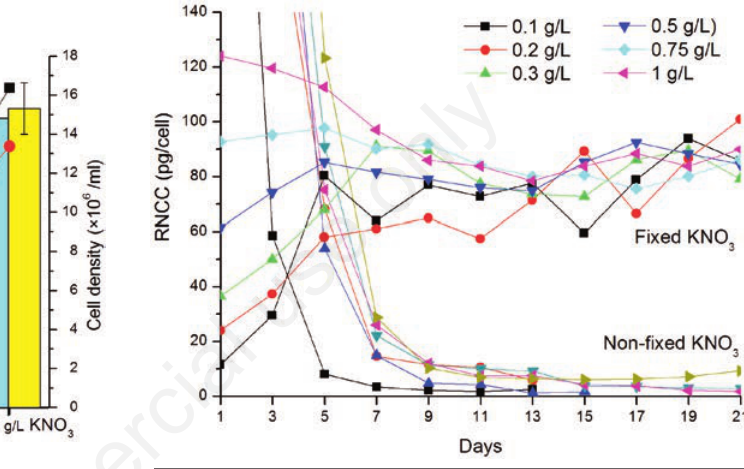
Figure 3. Remaining nitrate concentration in the culture of each cell under low light intensity. Fixed KNO concentration. KNO was one-time 3 3 ing KNO to the culture every two days for maintaining the same 3 concentration as the first day; Non-fixed KNO KNO at the first day. 3